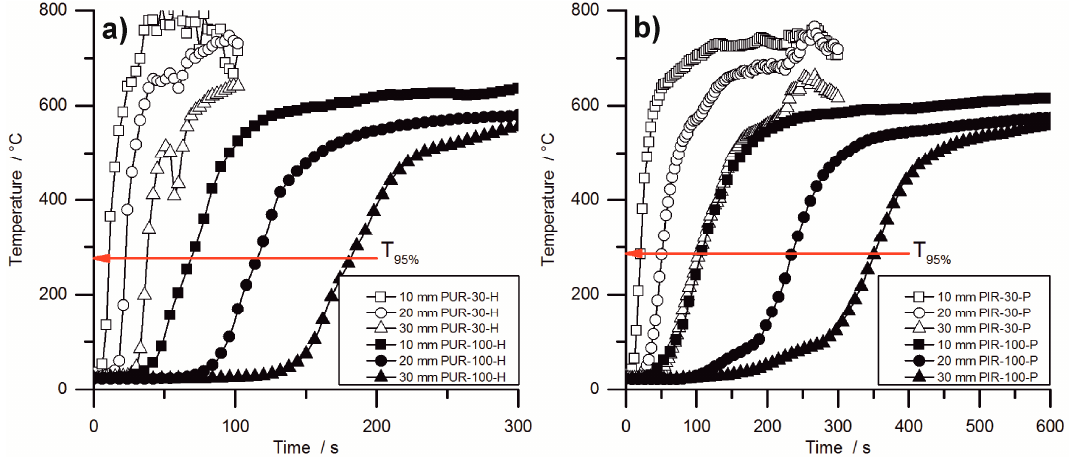
Figure 8. Temperature development inside ( a ) PUR-H and ( b ) PIR-P foams at densities of 30 and 100 kg/m³.